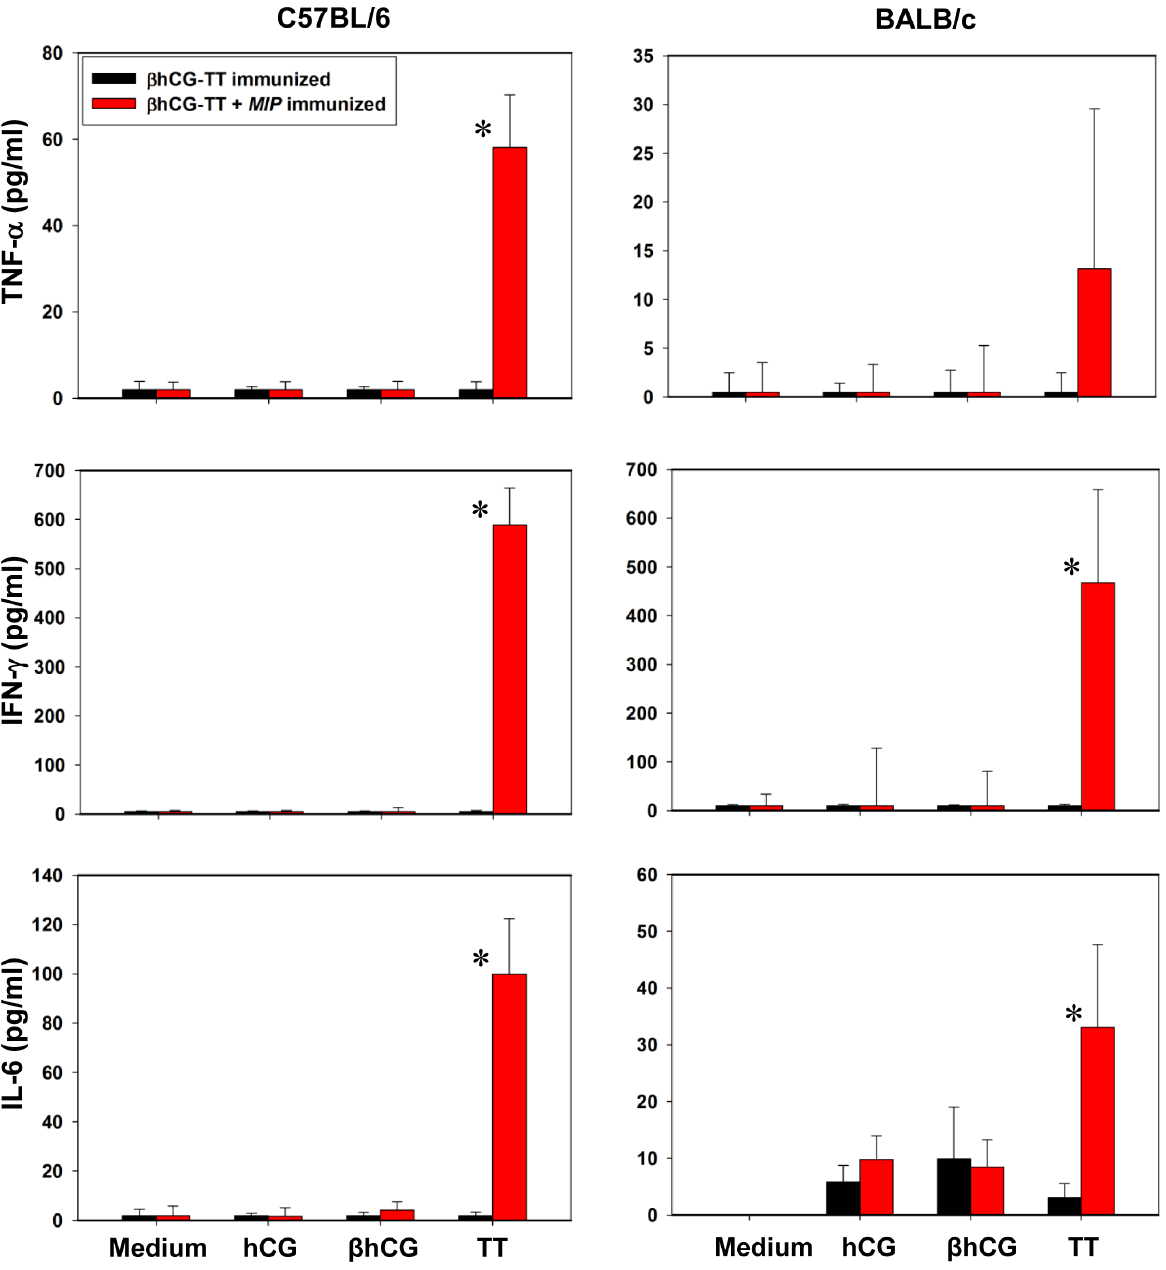
Figure 4. Cytokine recall responses. In vitro cytokine levels induced by hCG, b hCG or TT in splenocytes derived from b hCG-TT or b hCG-TT + MIP immunized BALB/c and C57BL/6 mice. Bars represent arithmetic mean 6 standard error. *p # 0.05 versus animals immunized with b hCG-TT.